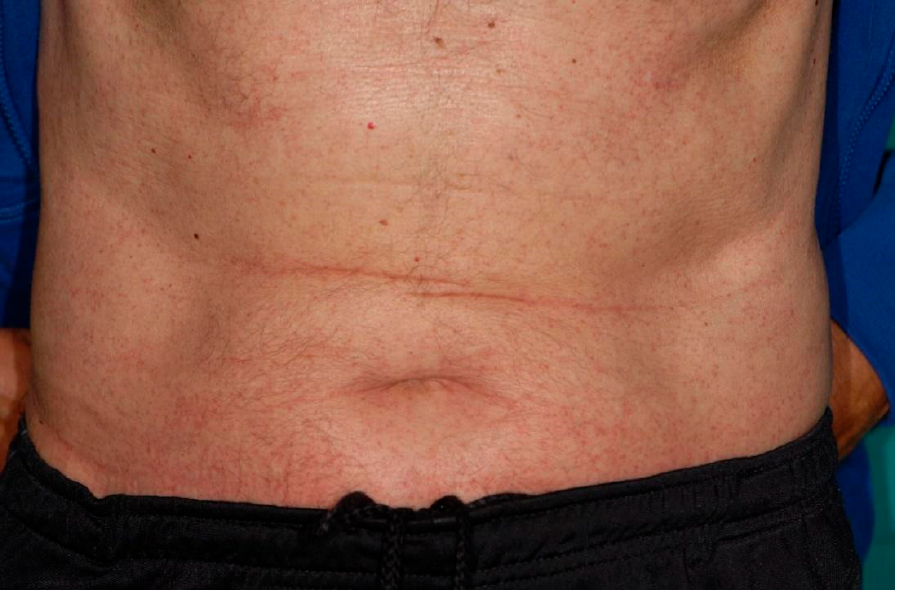
Figure 7. Skin rash erythema (Patient no. 7, Table 3).